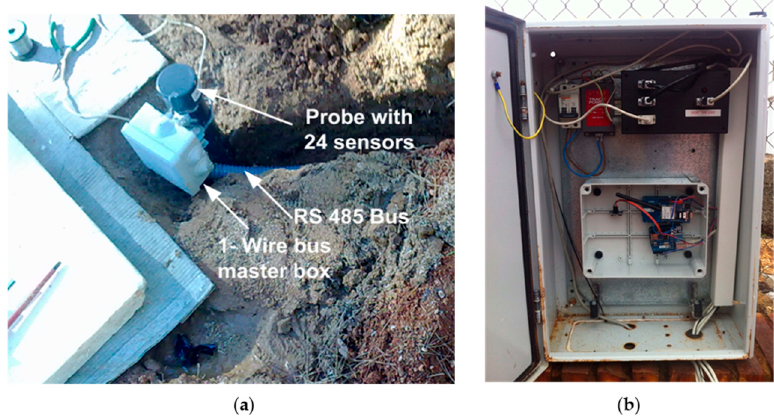
Figure 10. ( a ) Details of the buried GTP tip, box which houses the 1-wire bus master and RS 485 bus; ( b ) Waterproof box housing remainder elements of the measurement system.